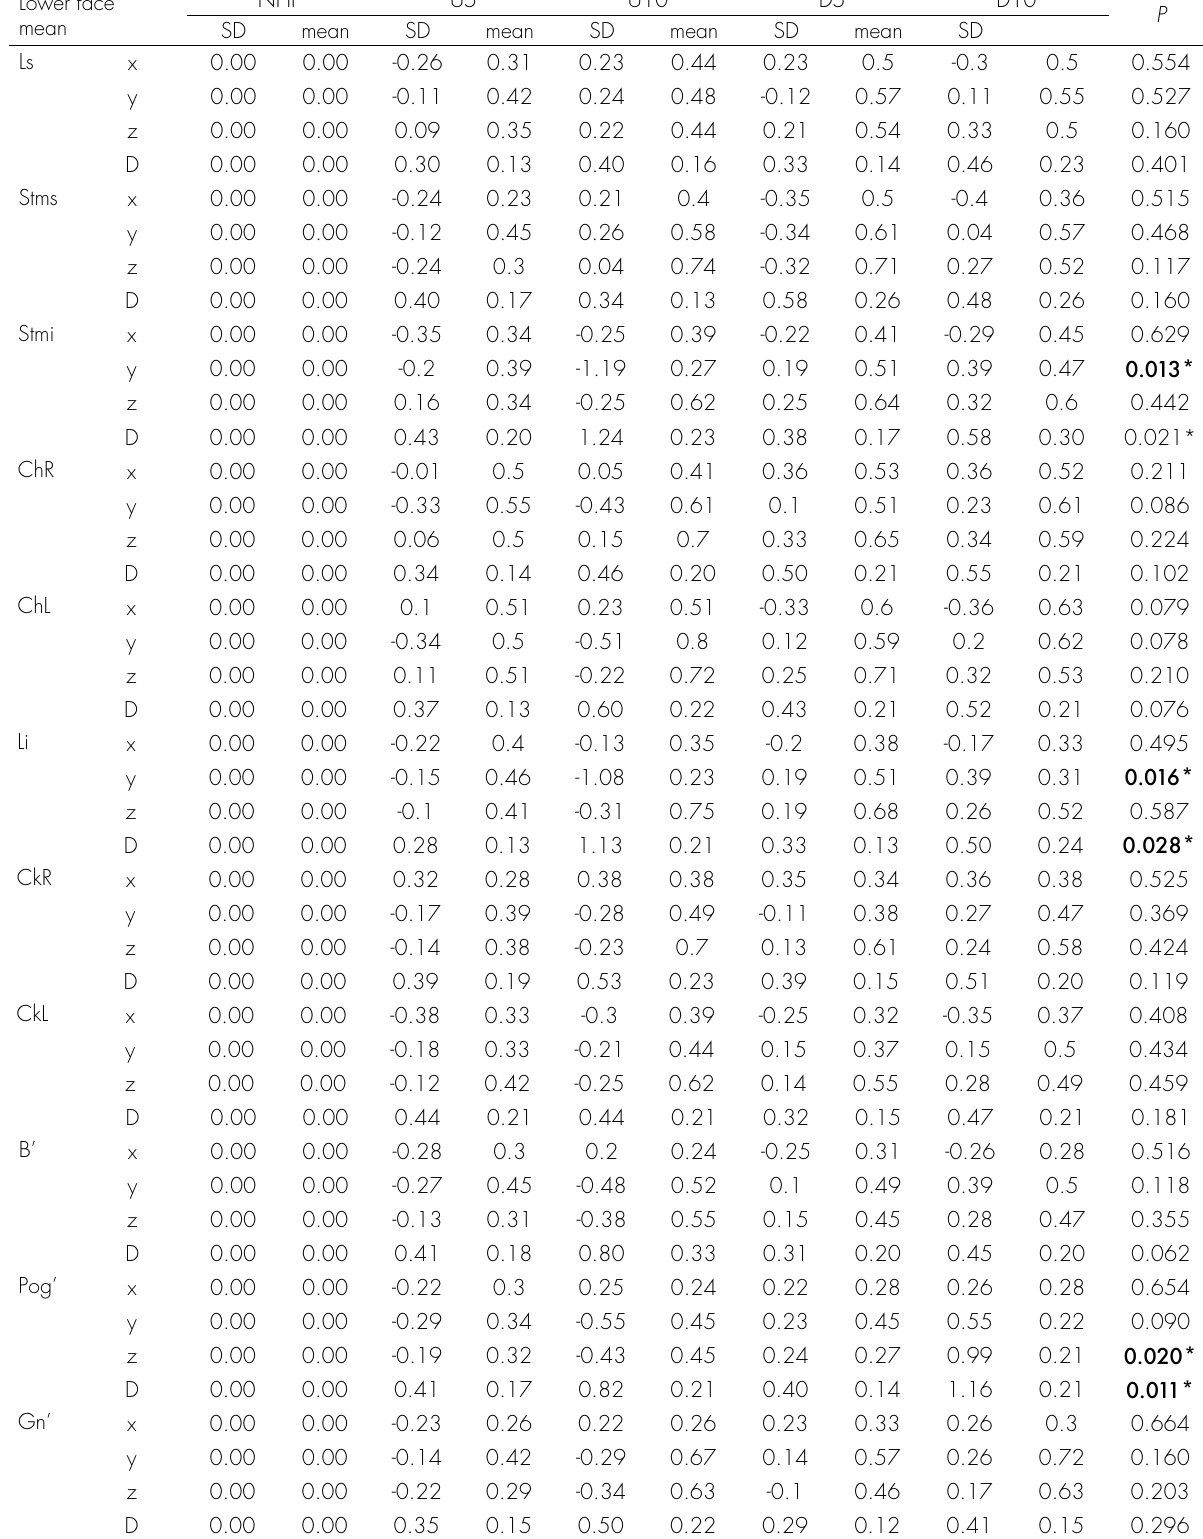
Table IV. Changes in the lower facial soft tissue landmarks according to head posture change (* p